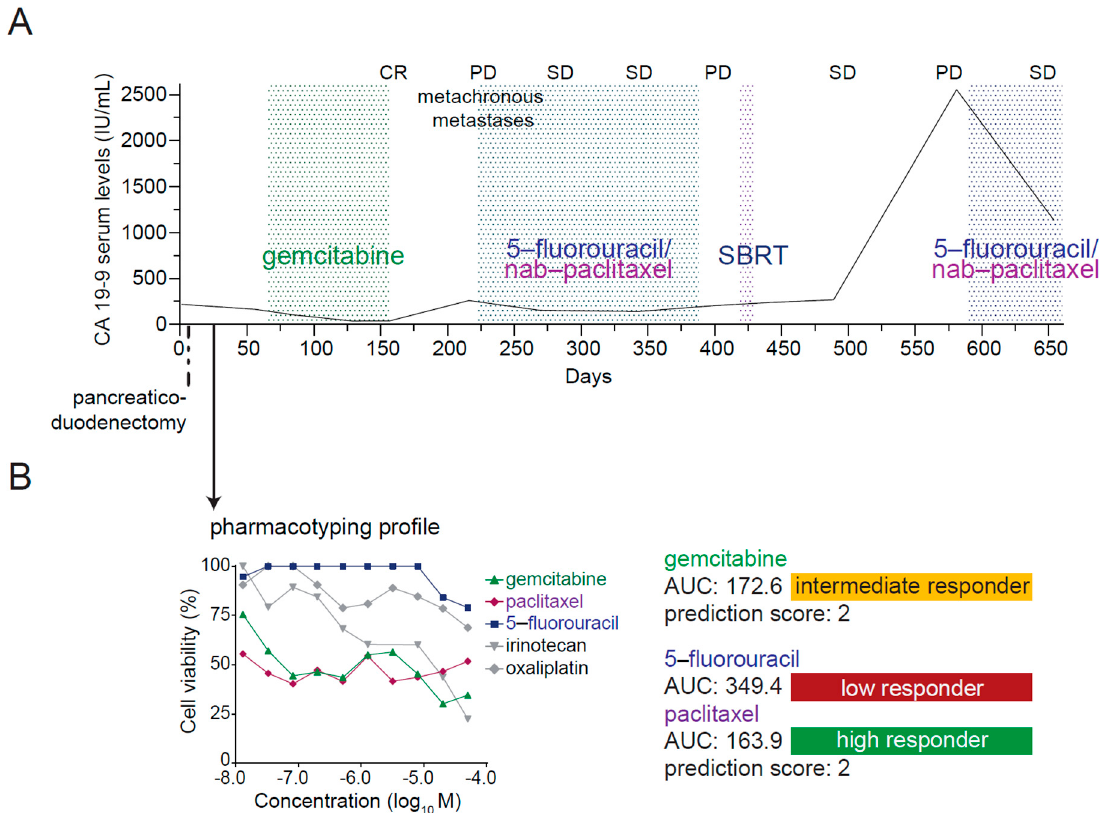
Figure 5. A clinical case demonstrating the feasibility of organoid-tailored therapy. ( A ), Treatment, diagnosis, and response to therapy and CA 19–9 serum levels of the patient. Time intervals for administered treatments are indicated between dotted lines. Patient-derived organoids (PDOs) were isolated from surgical specimens at the time of primary diagnosis of pancreatic ductal adenocarcinoma. The pharmacotyping profile was available after 32 days. ( B ), Cell viability analysis of gemcitabine, paclitaxel, irinotecan, 5-fluorouracil (5-FU), and oxaliplatin treatment in PDO 17 with the corresponding area under the curve (AUC) and classification into low, intermediate, or high responder category. CR, complete response; PD, progressive disease; SBRT, stereotactic body radiation therapy; SD, stable disease; AUC, area under the curve.